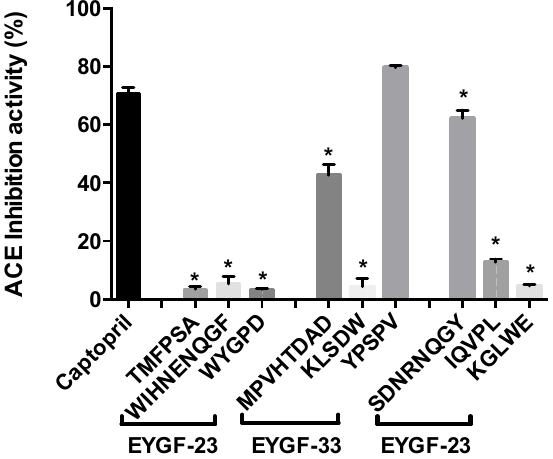
Figure 8. ACE inhibitory activity (%) of selected peptides. The activity of 10 mg/mL for each peptide to inhibit ACE was measured by HPLC. Captopril (0.5 mg/mL) was used as a positive control. Data correspond to the means ± SD of three independent experiments. ANOVA was performed in Graphpad Prism version 6.0 followed by Dunnett’s multiple comparisons test. The result was considered statistically significant versus captopril ( * = p < 0.05).